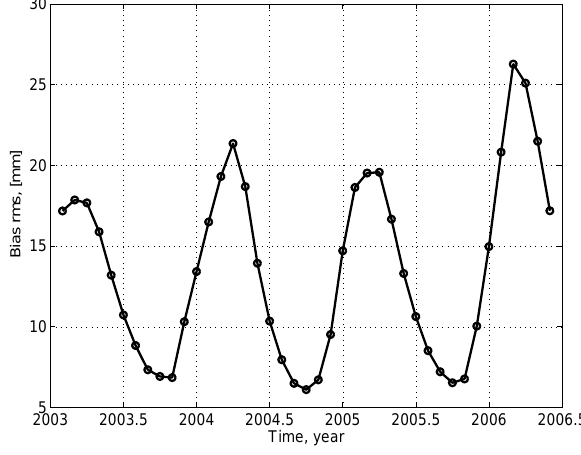
Fig. 8. RMS of the monthly bias caused by 30% noise in rain- fall numbers for the upper Zambezi target area. 1000km Gaussian smoothing applied.